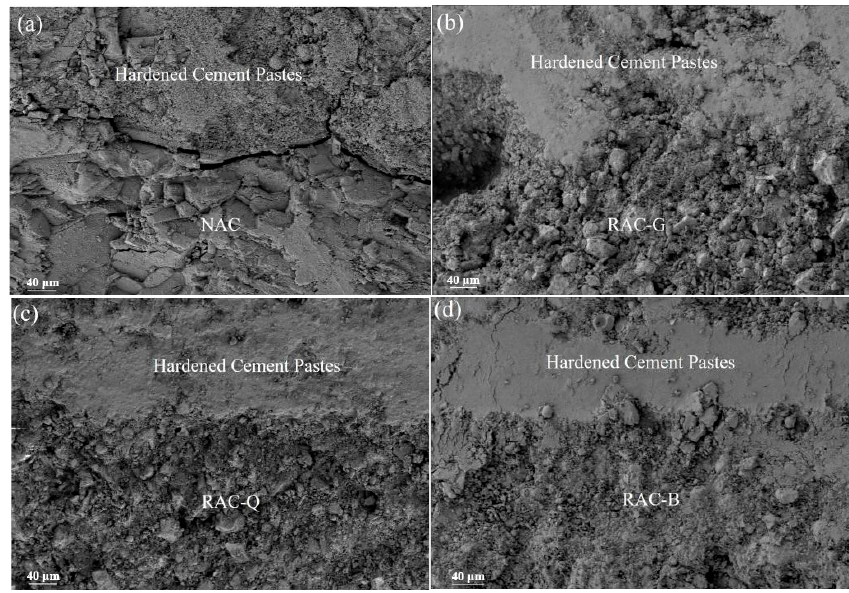
Figure 6. Micro morphology of interface between different coarse aggregate and paste.